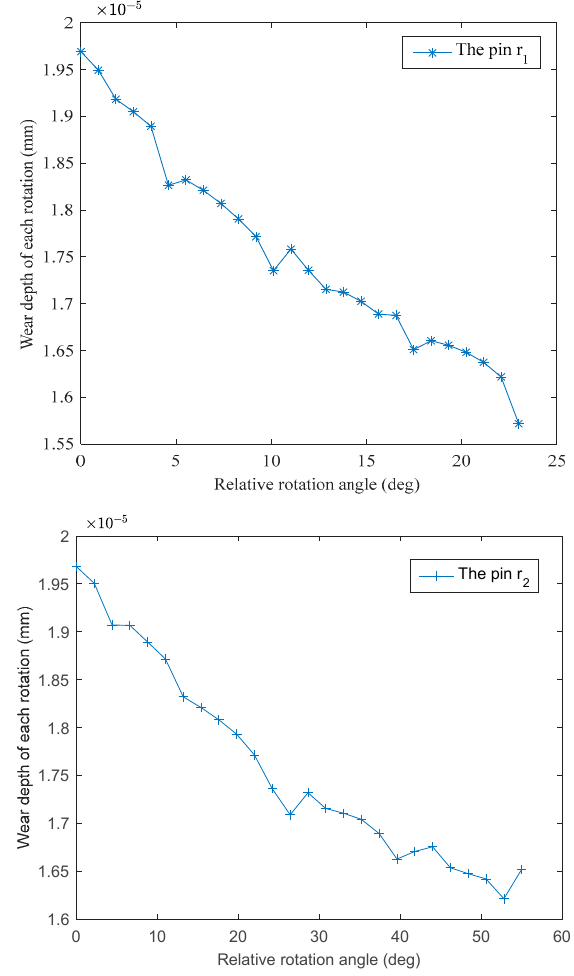
Figure 6. Wear depth of different pins of a single rotation cycle.